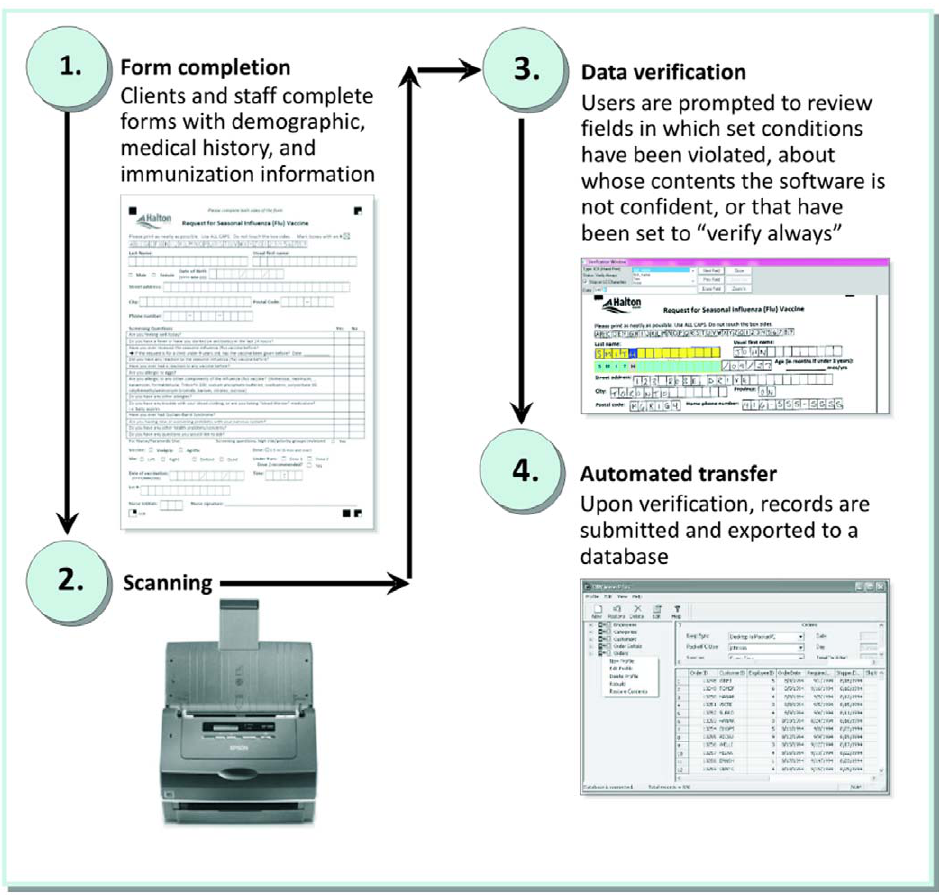
Figure 1. Data Flow.